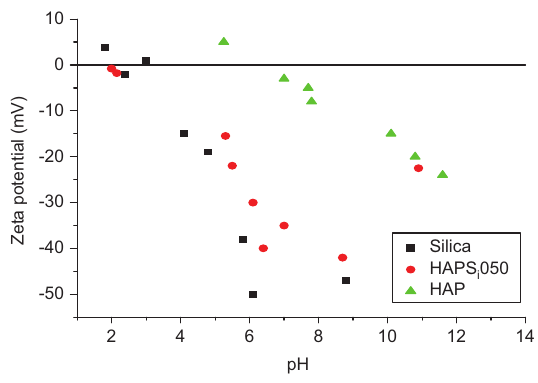
molecules and one exothermic peaks at 506 ° C, corresponding to the combustion of dodecyl organic molecules.